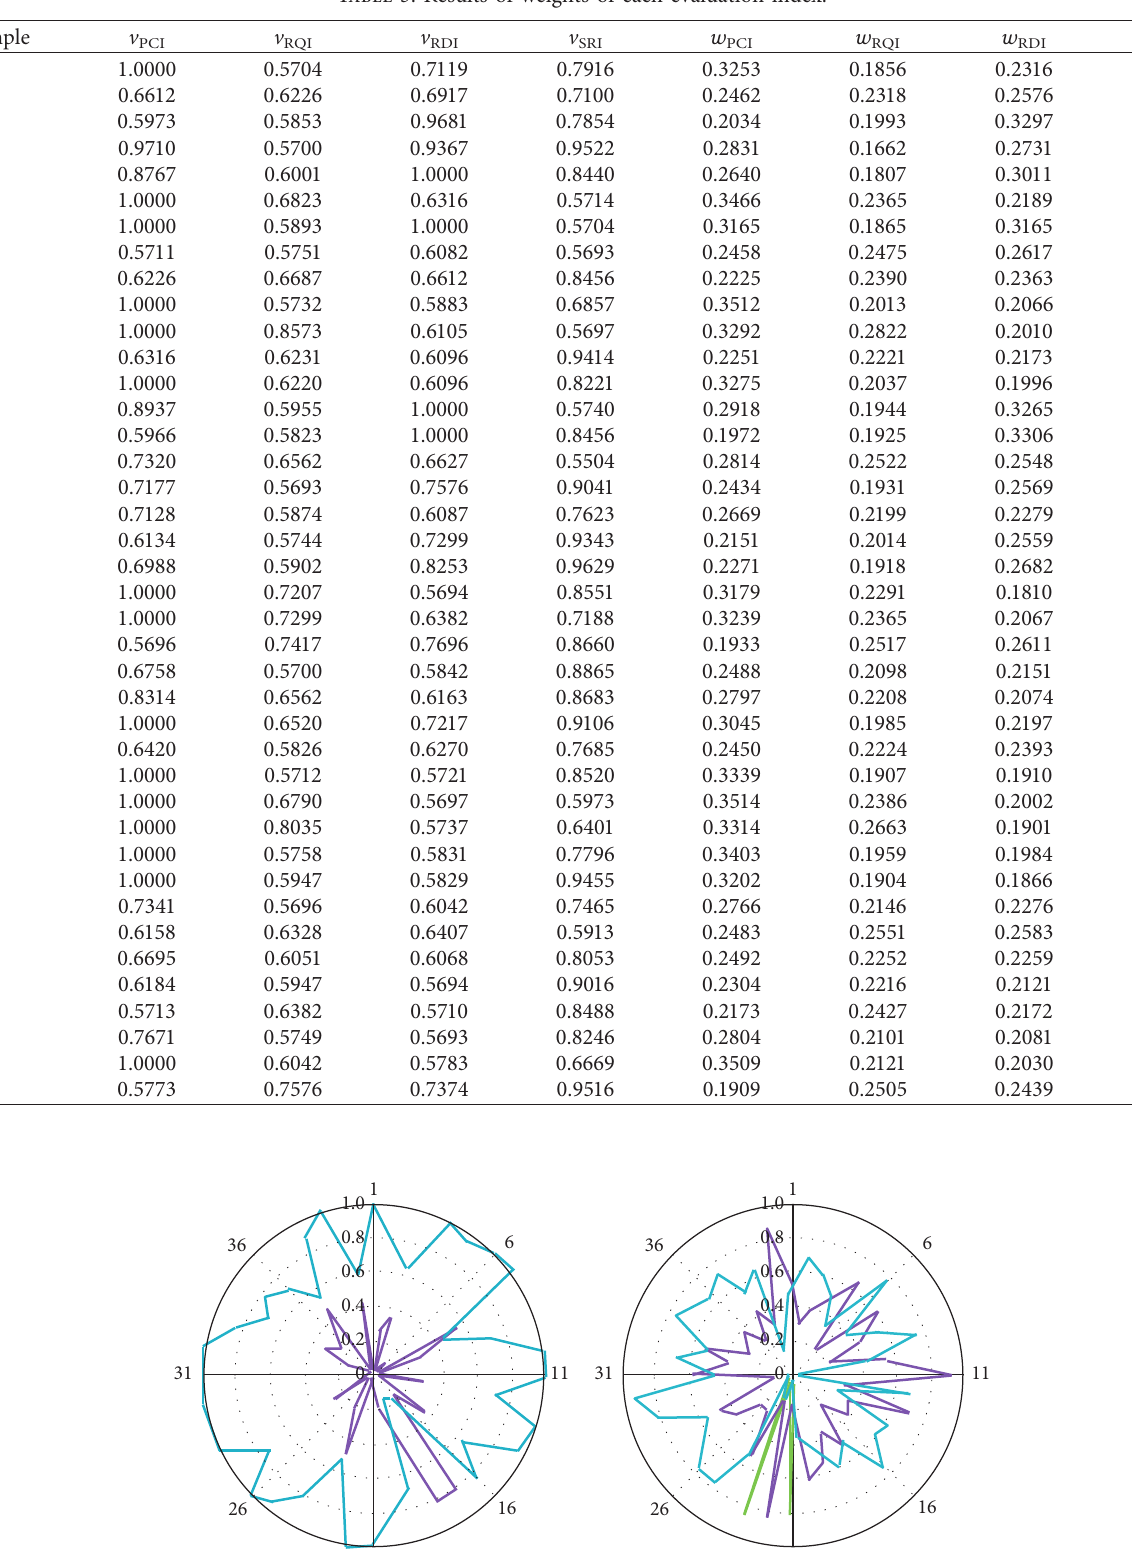
Table 3: Results of weights of each evaluation